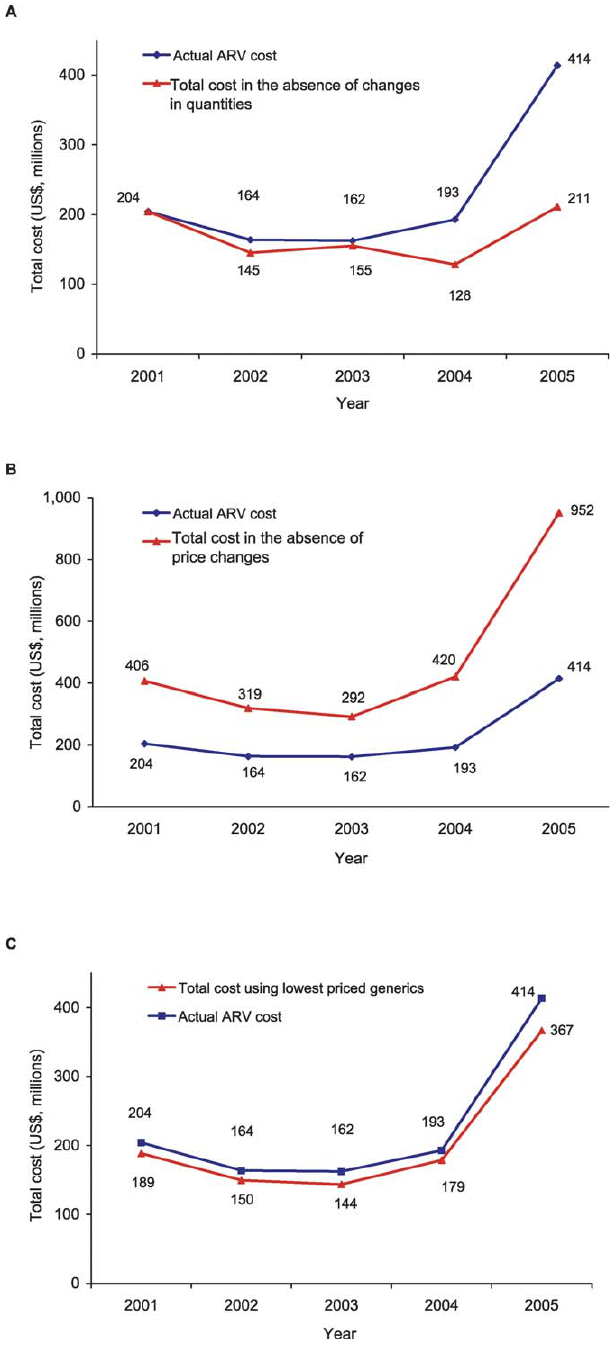
Figure 6. Impact of Alternative Price and Quantity Scenarios on Total ARV Costs, 2001–2005 (A) Total Cost Estimates in the Absence of Changes in Drug Quantities,